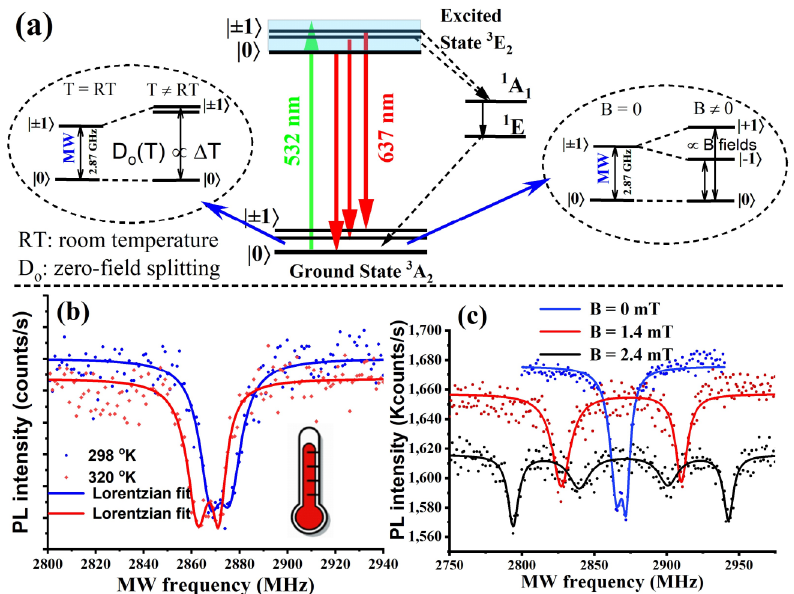
Figure 3. ( a ) An illustration of the energy diagram of the NV center’s ground spin states in the BNDs. The left and right dotted circles in Figure 3 ( a ) demonstrate how the zero-field splitting (D 0 )of the NV center varies depending on the temperature (T) and magnetic field (B) changes. RT symbol in ( a ) (left inset) stands for room temperature. ( b ) Optically detected magneto resonance (ODMR) spectrum of the NV center in BNDs at two different temperatures, 298 K and 320 K. ( c ) ODMR spectrum splitting due to different magnetic field values (0, 1.4, and 2.4